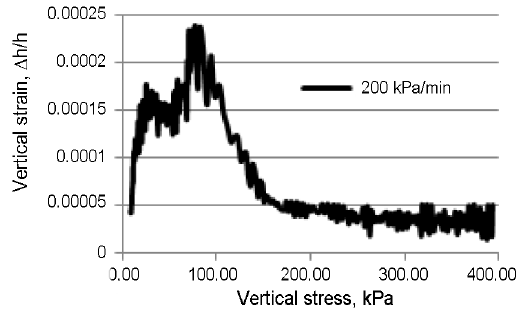
Fig. 12. Vertical stress versus vertical strain (200.0 kPa/min)